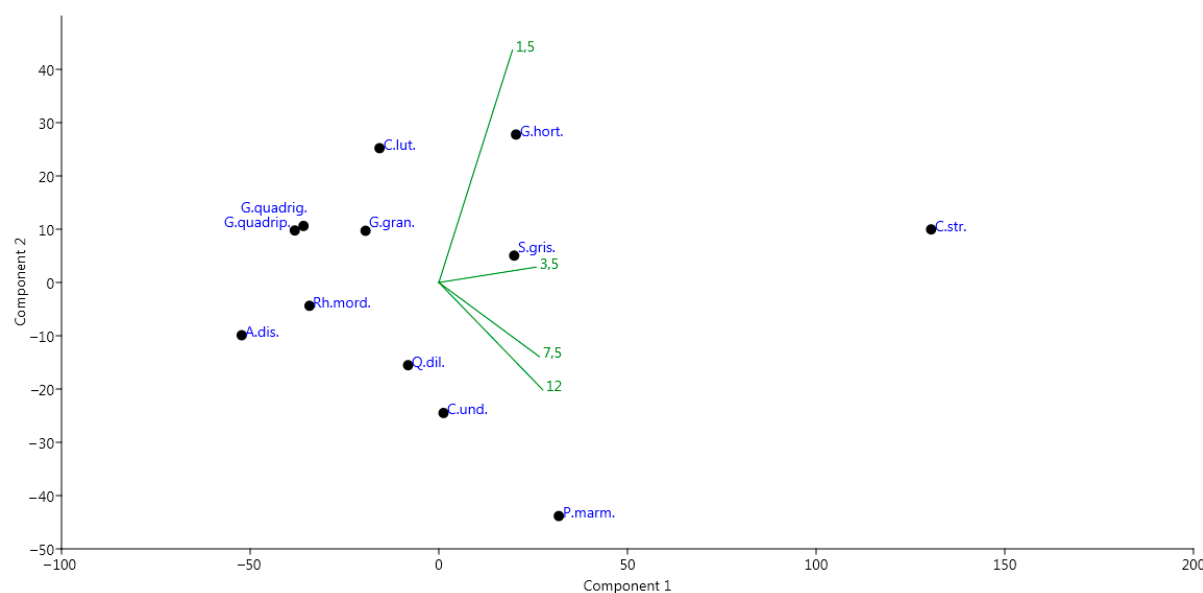
Figure 7. Principal component analysis (PCA) ordination diagram of the species occurrence species in the Republic of Mordovia (European Russia) based on species occurrence of frequency at various height of bait trap positions (1.5 m, 3.5 m, 7.5 m, 12.0 m). Designation of species follows one in Figure 5.